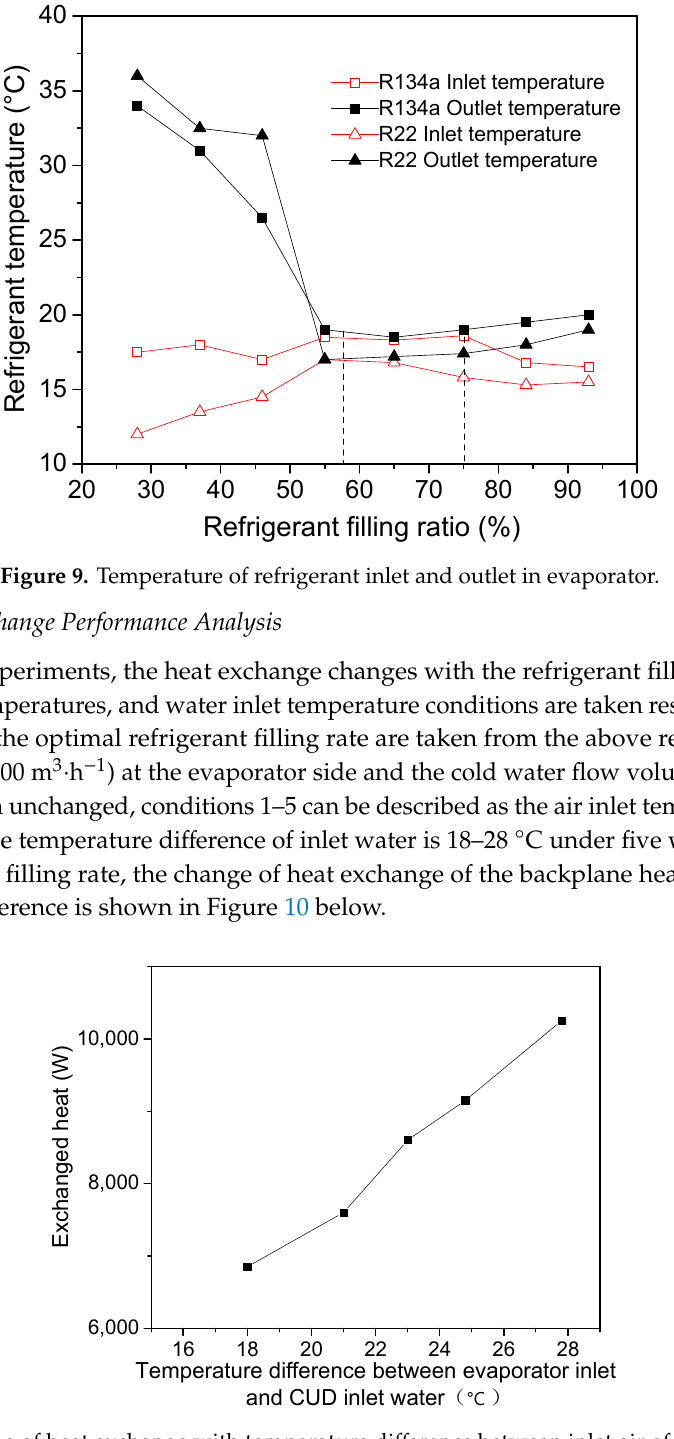
Figure 8. Heat exchange and refrigerant inlet and outlet pressure in evaporator.